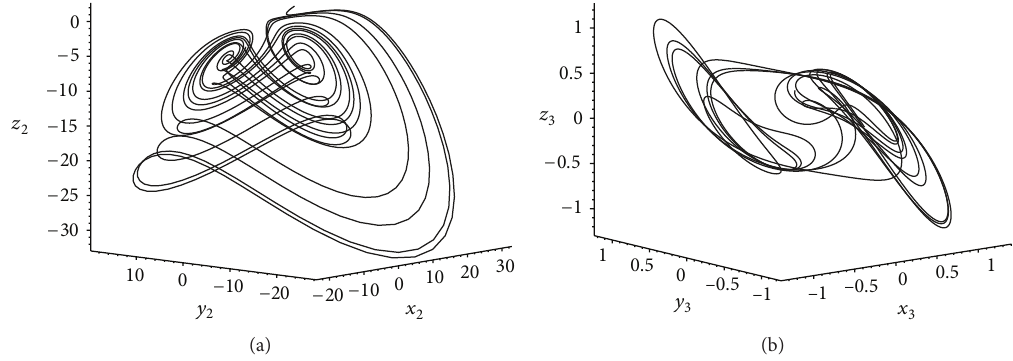
Figure 2: The chaos attractor of new chaotic system (a) and the Coullet system (b).